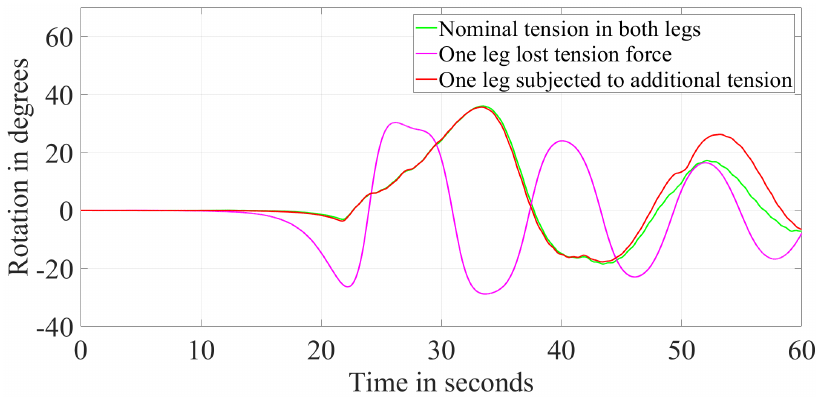
Figure 21. Comparison of rotation at tower top before and after fault rupture.